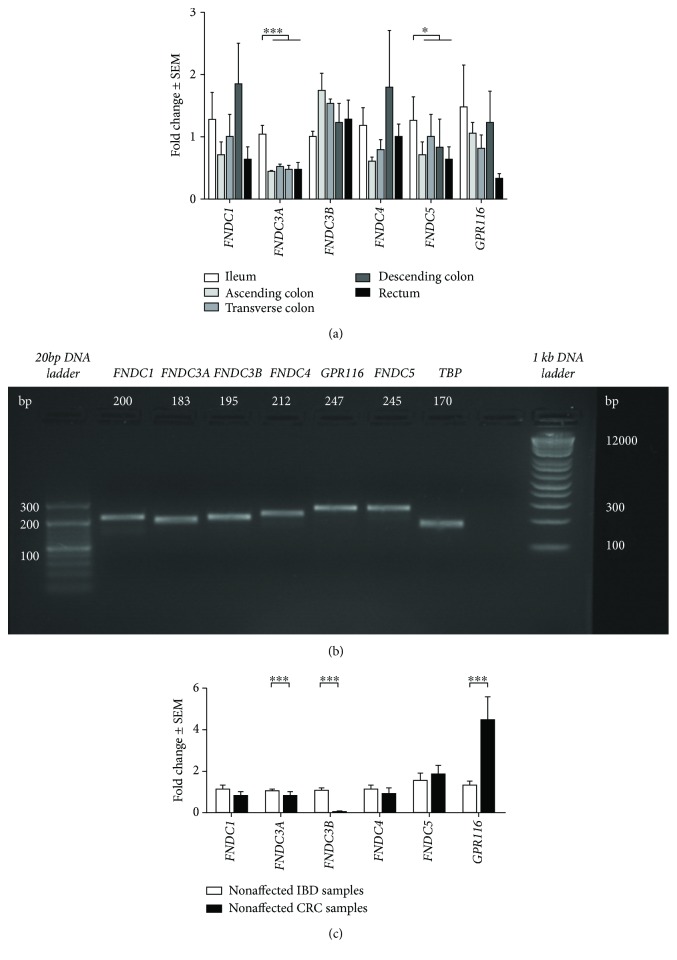

FNDCs and GPR116 expression in nonaffected human mucosal samples. FNDC1, FNDC3A, FNDC3B, FNDC4, FNDC5, and GPR116 in nonaffected mucosal samples along the proximal-distal axis (n = 4-5) (a). Representative agarose gels of qRT-PCR products, including the expected amplicon lengths for each gene (b). Quantification of FNDC1, FNDC3A, FNDC3B, FNDC4, FNDC5, and GPR116 in nonaffected samples of patients with IBD (n = 22) and CRC (n = 7-10) (c). Data are expressed relative to the expression in nonaffected IBD samples and normalized to the housekeeping genes ACTB and TBP. ∗
p < 0.05, ∗∗
p < 0.01, and ∗∗∗
p < 0.001.